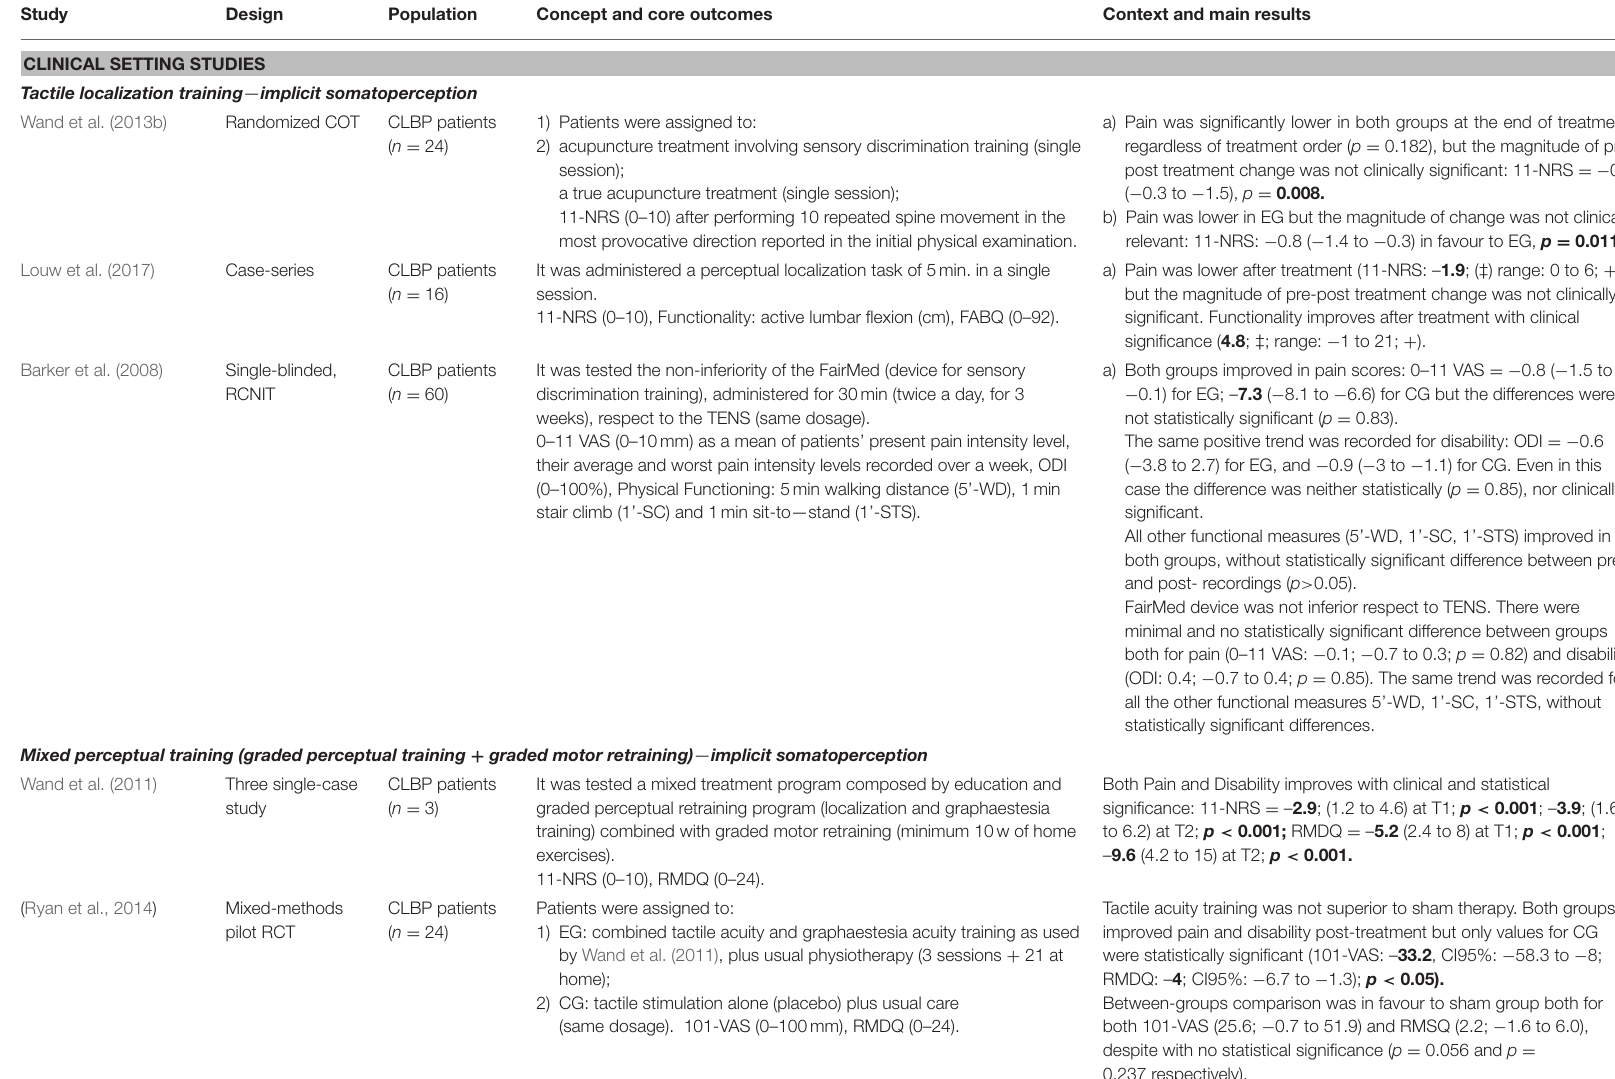
TABLE 4 | Synopsis of included intervention